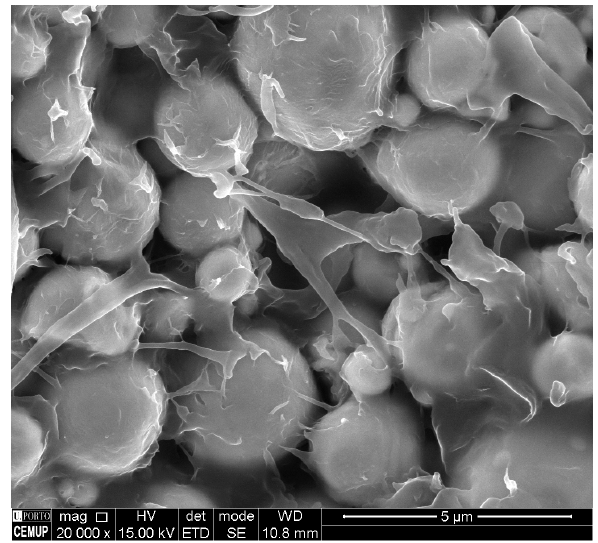
Figure 3. Feedstock for powder hot embossing (316L powder and M1, commercial binder), SEM